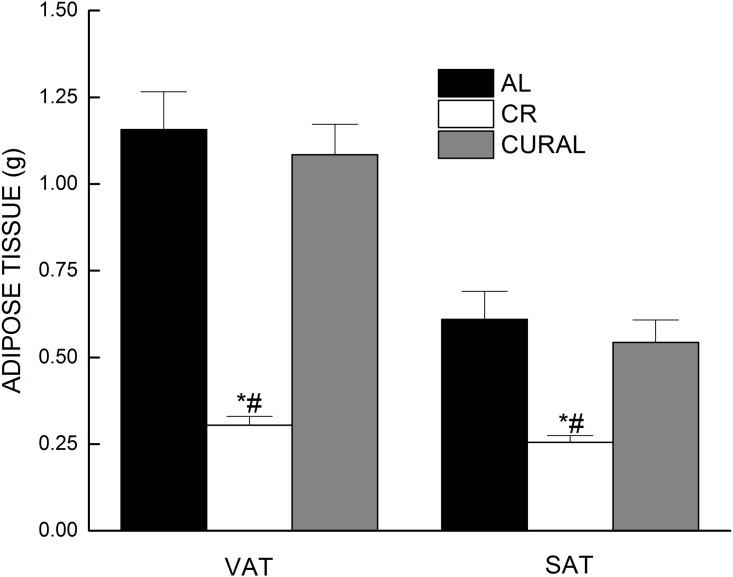
Adipose tissue weights after 12 weeks of dietary treatment.Data are means ± SE, n = 18–19. Visceral adipose tissue (VAT) was collected from epididymis and, subcutaneous adipose tissue SAT was collected from the gluteal region. Symbols indicate differences, P < 0.05: (a) different from AL (*), (b) different from CURAL (#).